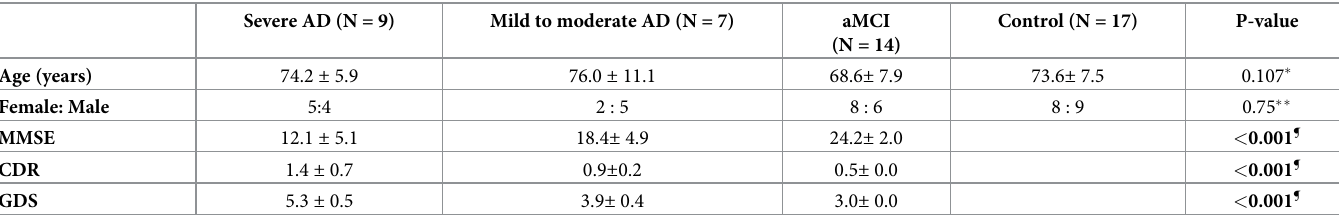
Table 1. Demographics of the four groups.